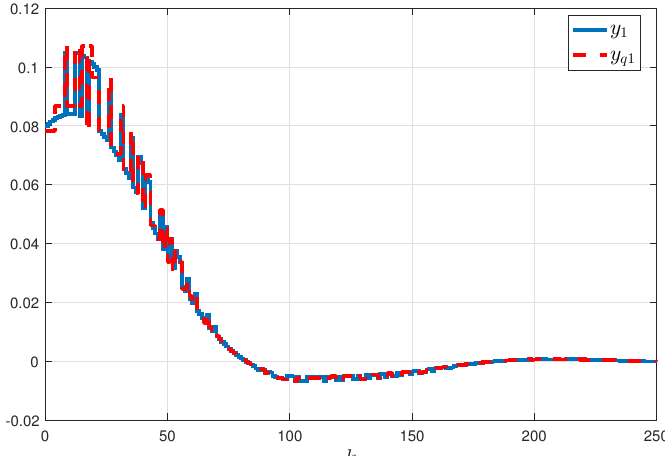
Figure 2. Actual output, y 1 , and quantized output, y q 1 .